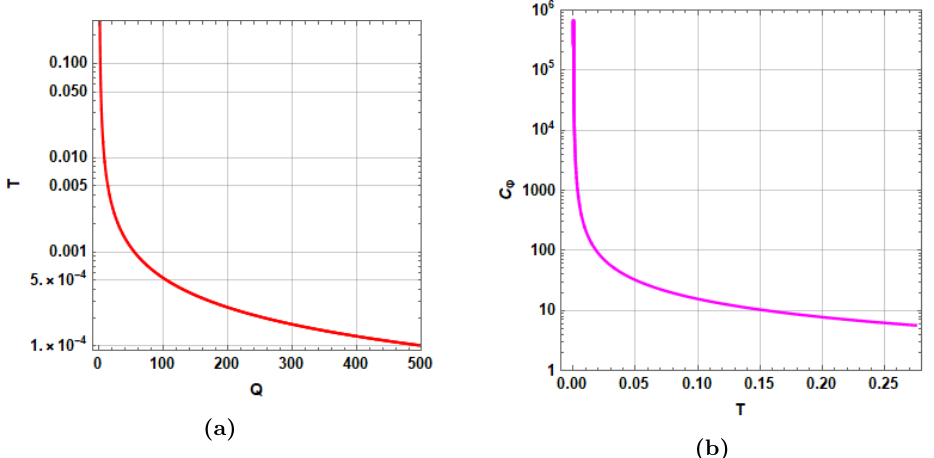
Figure 31. (a) Temperature as a function of black hole charge during absorption of 10 5 particles with a fixed electric charge dQ = 0 . 005 . (b) Heat capacity at the constant electric potential in terms of black hole temperature during absorption of 10 5 particles with a fixed electric charge dQ = 0 . 005 . The initial conditions are Q 0 = 1 , l = 1 , M 0 = 1 . 67 , r h = 1 . 1 and D = 4 .